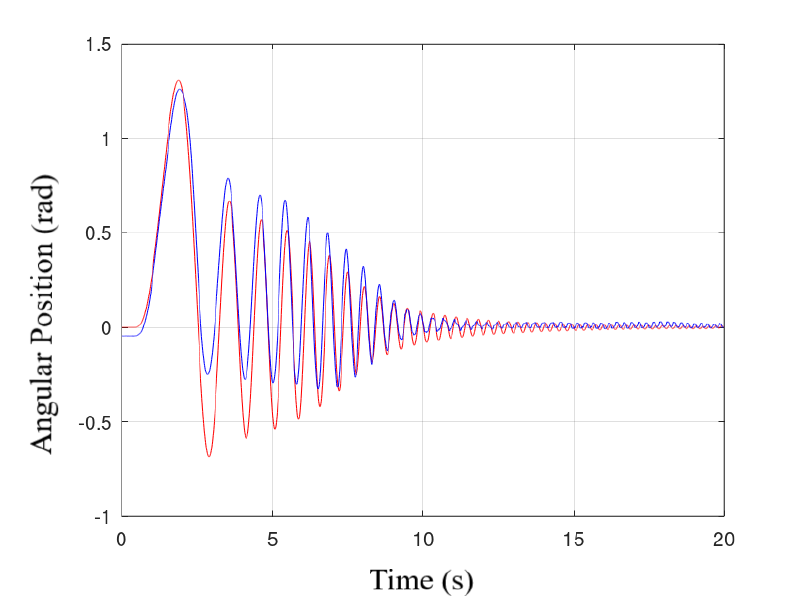
Figure 7. Non-Rigid joint model vs. real angular